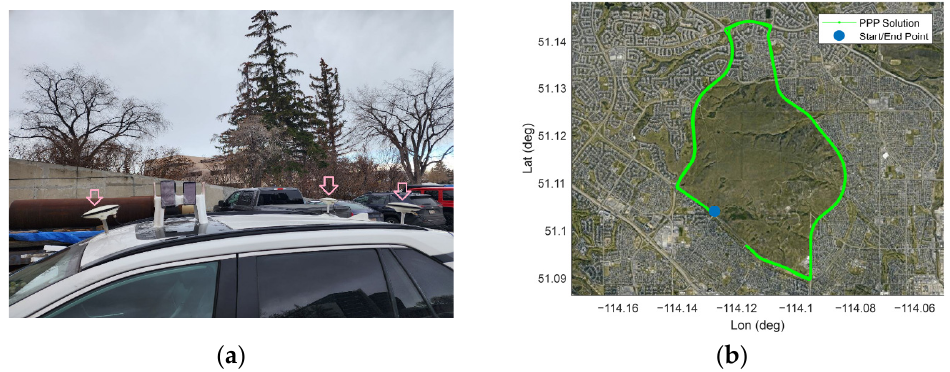
Figure 9. A kinematic experiment conducted on 22 April 2022: ( a ) test configuration and ( b ) reference trajectory [33].